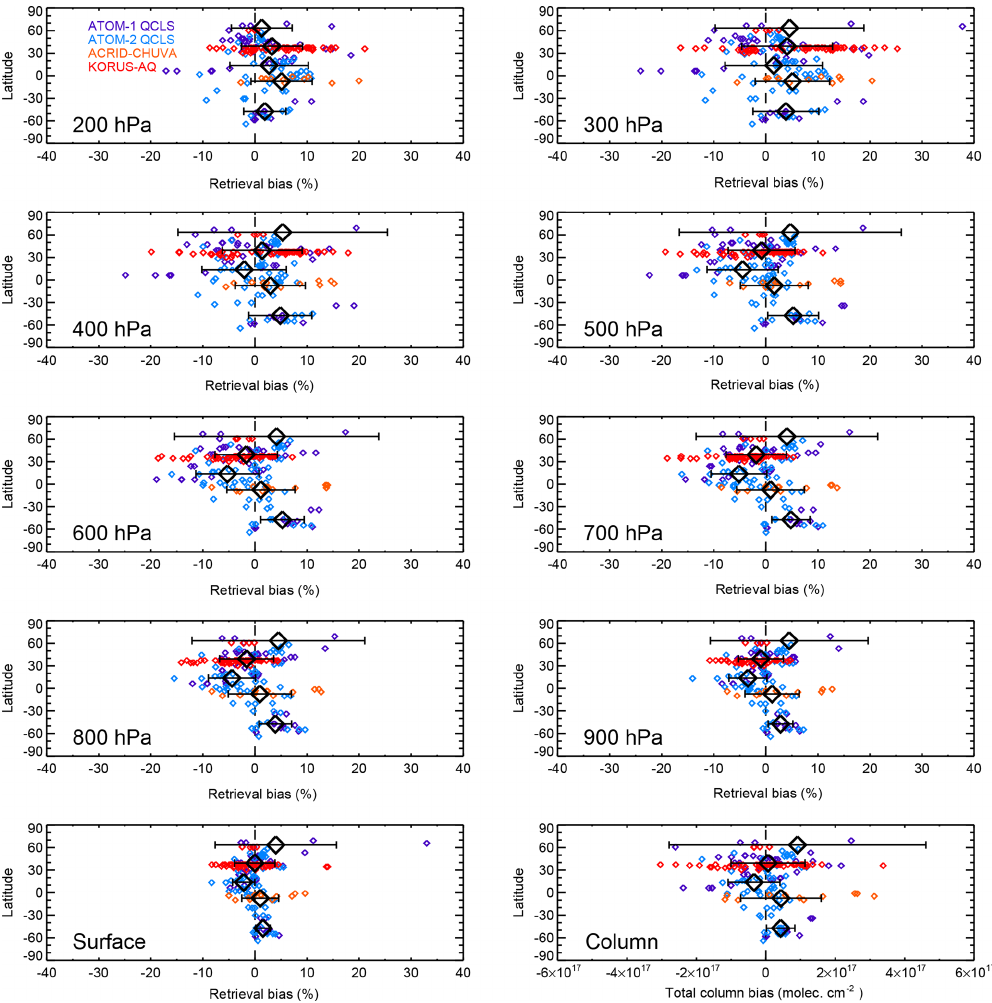
Figure 8. V8 TIR-only biases based on the ATom (phases 1 and 2), ACRIDICON, and KORUS-AQ CO profiles. Results are color-coded as indicated by the key in the top-left